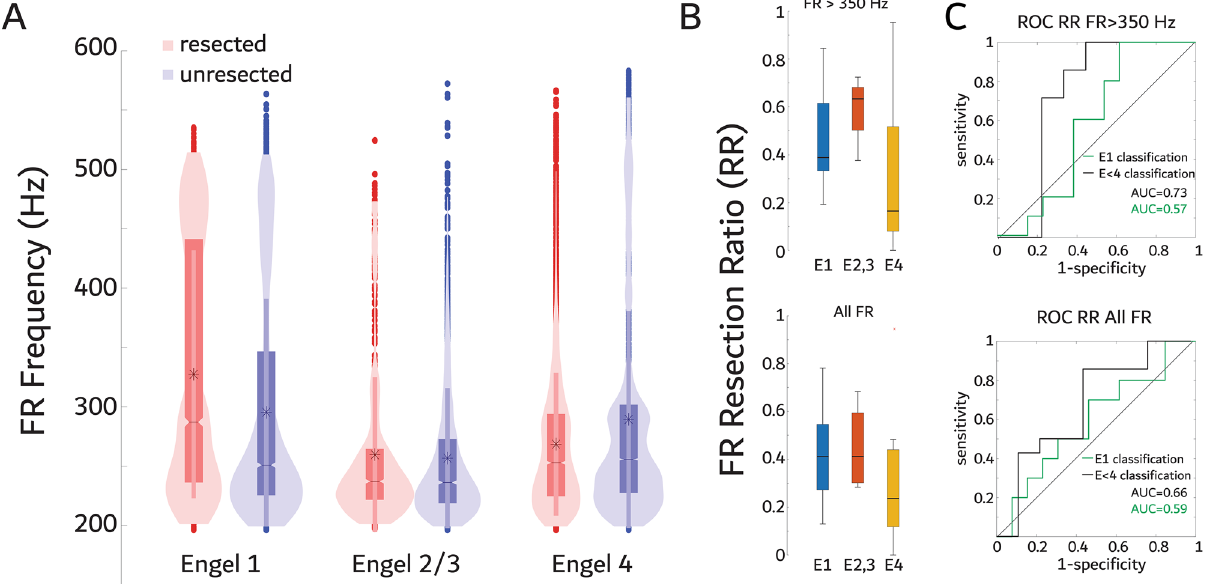
Figure 2. Correlates of fast ripple (FR) resection ratios and relative rates with outcome. (A) Violin plots of FR frequency distribution stratified by the resected electrodes and post-operative seizure outcome Engel (E) class. Fast ripples were increased in frequency in the resection margins of E1 patients (GLMM, p < 1e-10), but decreased in frequency in the resection margins of E2-4 patients (GLMM, p < 1e-8)(B) Box plot of the FR resection ratio (RR) stratified by Engel class for FR > 350 Hz (top, p > 0.05 spearman rank correlation) and all FR irrespective of frequency (bottom, p > 0.05 spearman). (C) Receiver operating characteristic (ROC) curves of seizure-free classification (E1,green) and improvement classification (E < 4,black) by FR > 350 Hz rates (top) and all FR rates (bottom) including the area under the ROC curve (AUC). The RR cutoff was 0.192 and 0.366 for FR > 350 Hz and all FR for seizure-free classification, respectively. The RR cutoff was 0.192 and 0.272 for FR > 350 Hz and all FR for improvement classification, respectively.